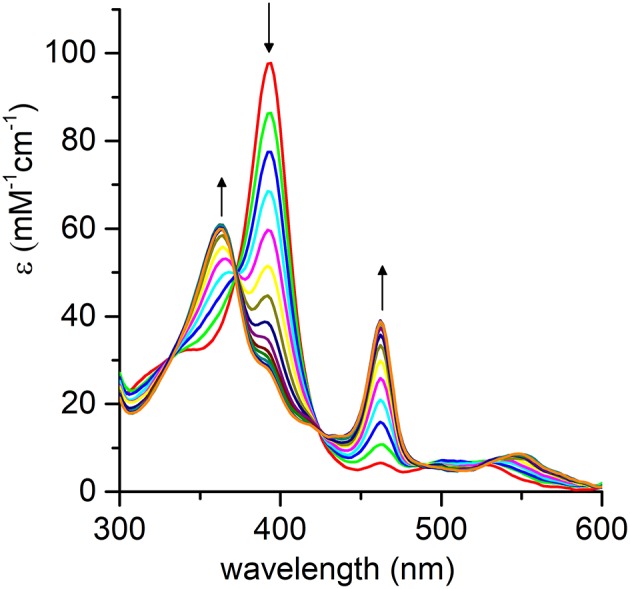
Evolution of the UV-vis absorption spectrum of [MnIV = O]·+ upon addition of thioanisole (100 eq.); arrows indicate the direction of absorbance variations. Reaction conditions: Mn-MC6*a, 20 μM; H2O2, 2.0 mM; thioanisole 2.0 mM; 60 mM carbonate buffer with 40% TFE (v/v), pH 9.5; T = 25°C.